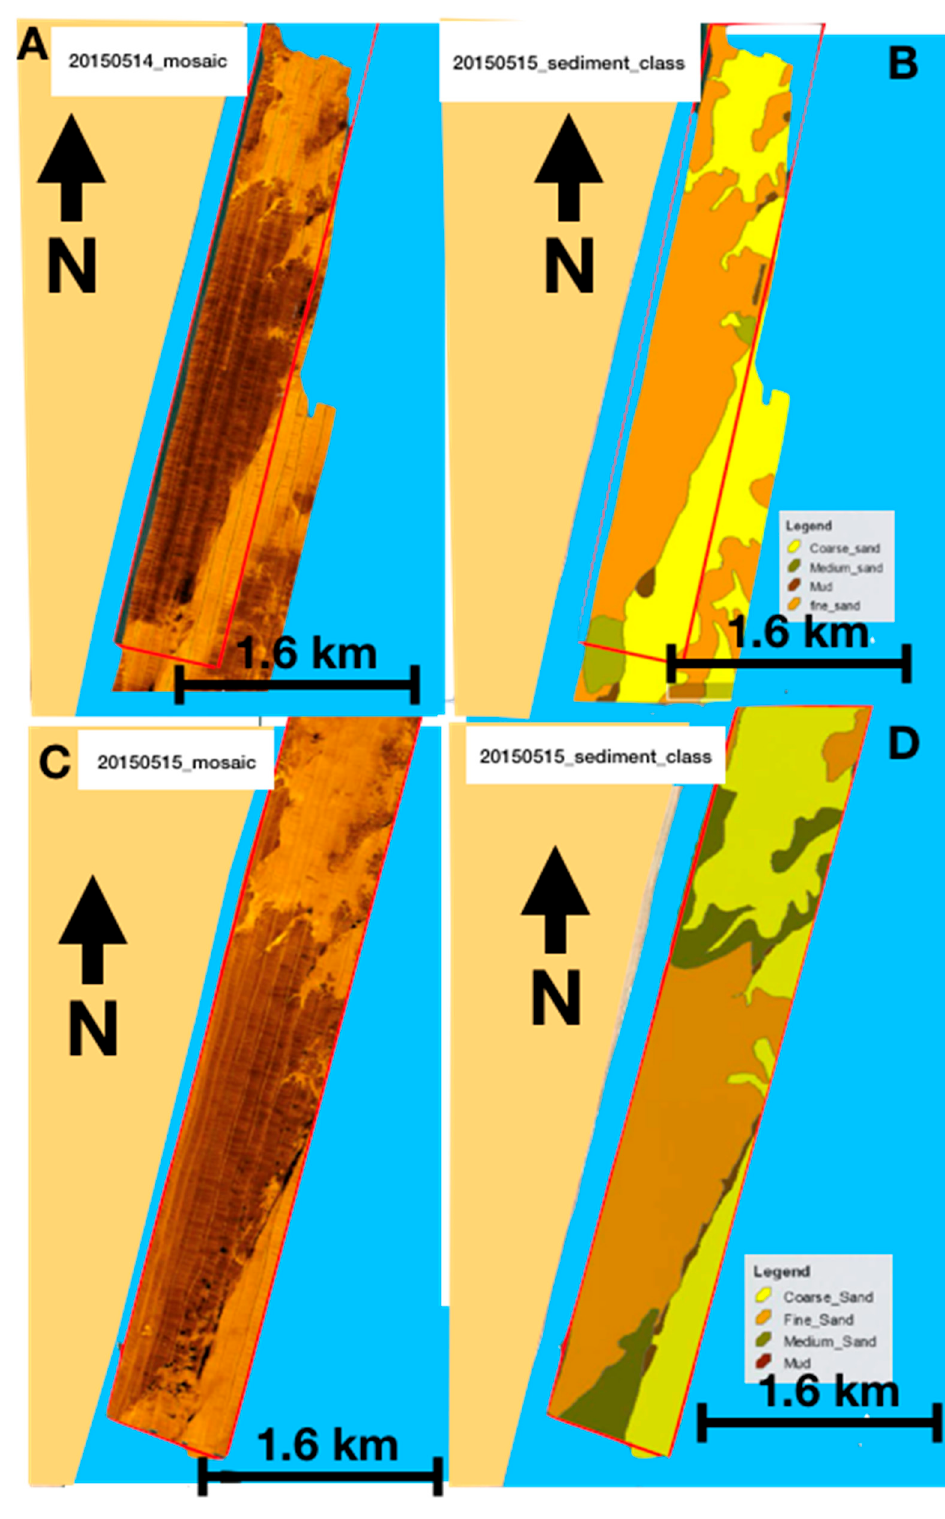
Figure 18. Side-scan sonar mosaic interpretation, Assateague Island National Seashore, Maryland. ( A ) Side-scan sonar mosaics collected during 14 May 2015; ( B ) interpretation of side-scan sonar data collected in 14 May 2015; ( C ) side-scan sonar mosaics collected in October 2015; ( D ) interpretation of side-scan sonar mosaics collected in October 2015. Note that red polygons represent the same areas mapped during both 14 May 2015 and October 2015.